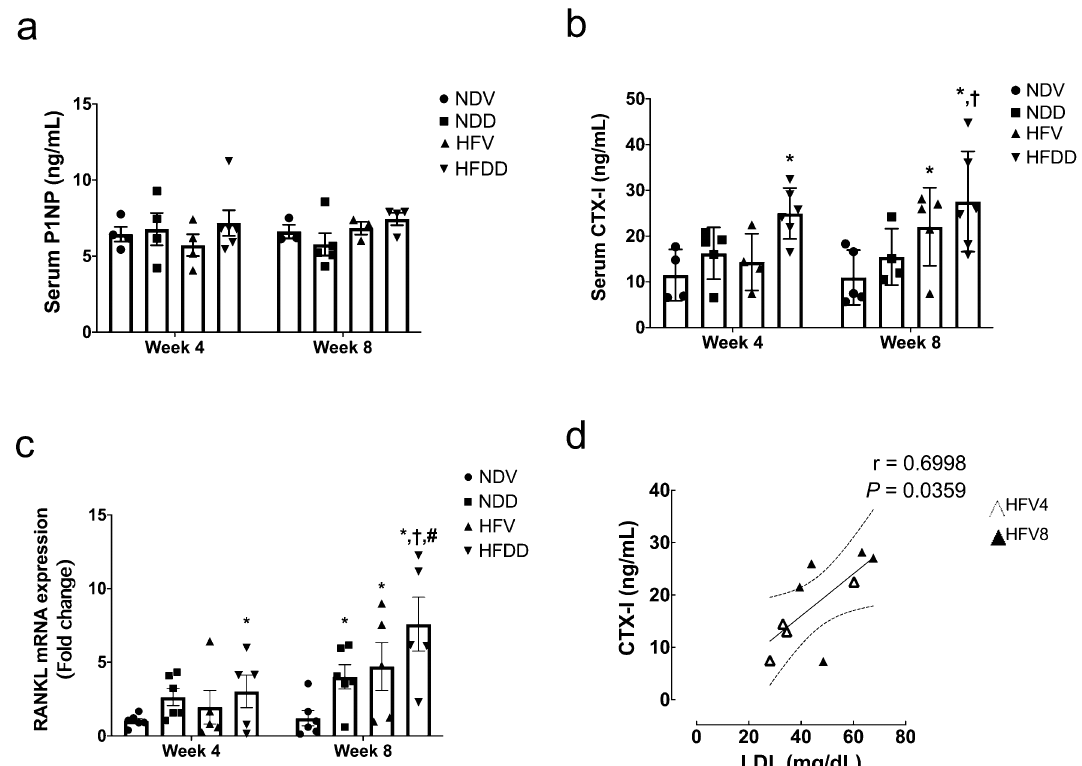
Figure 4. D-galactose-induced aging aggravated bone resorption markers in the obese-insulin resistant condition. ( a ) Levels of P1NP in serum at the indicated time points, ( b ) Levels of CTX-I in serum at the indicated time points. Bar graphs are presented as mean ± SEM (n = 4–6/ group). ( c ) RANKL mRNA expression in bone tissues at the indicated time points. ( d ) Correlation between CTX-I and LDL. * p < 0.05 versus NDV at the same time point, † p < 0.05 versus NDD at the same time point , ‡ p < 0.05 versus HFV at the same time point , # p < 0.05 versus same group at the different time point. CTX-I, C-terminal telopeptide of type I collagen; HFDD, high-fat diet with D-galactose; HFV, high-fat diet with vehicle; NDD, normal diet with D-galactose; NDV, normal diet with vehicle; P1NP, procollagen type I N-terminal propeptide; RANKL, receptor activator of nuclear factor κB